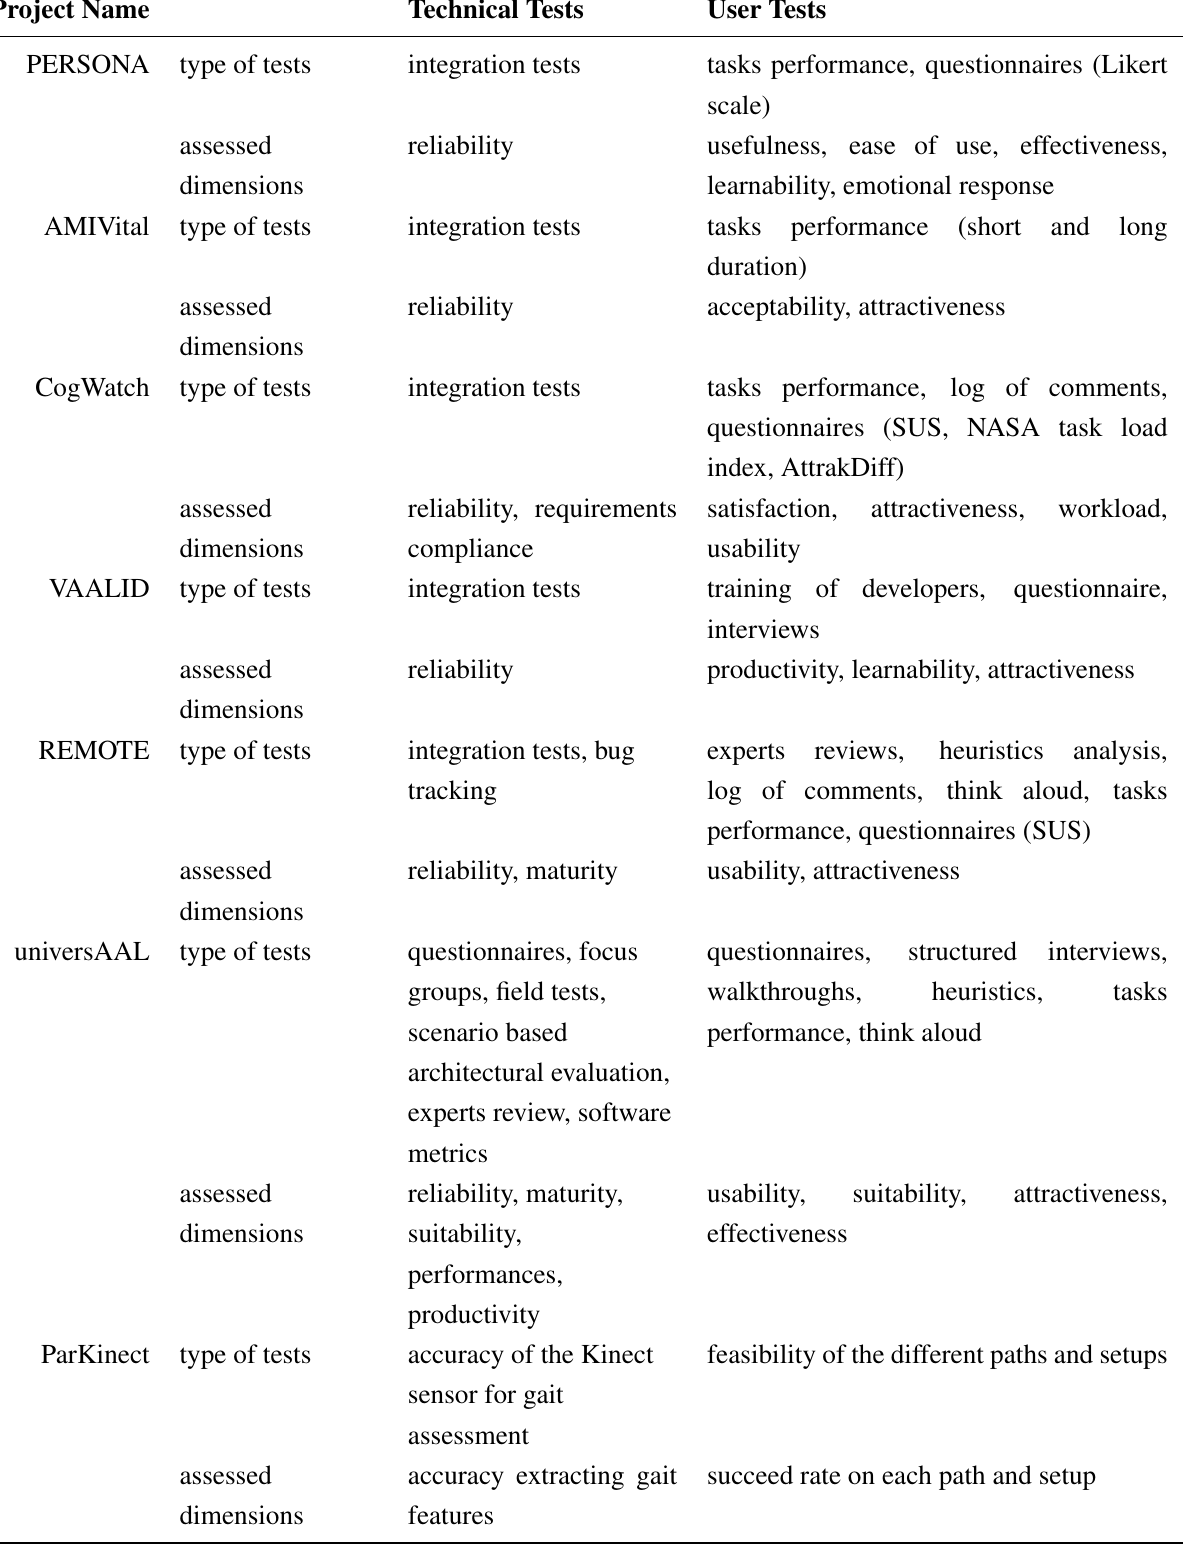
Table 2. Summary of the evaluation methodologies used in our projects. SUS, system usability